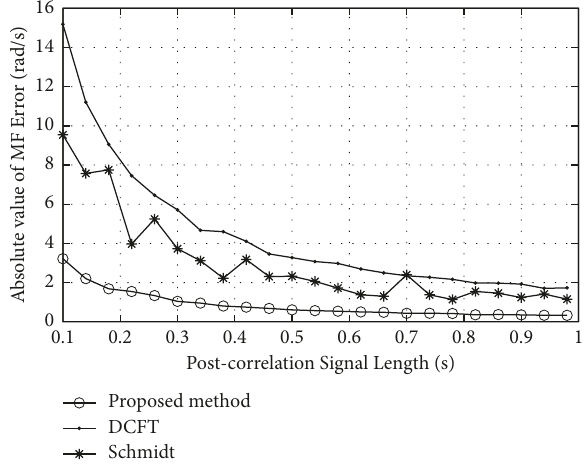
Figure 6: MF square error comparison. The SNR of the post- correlation signal is 5dB. The MF search step is 1 rad/s. The in- tegration time is 200ms in coarse MF